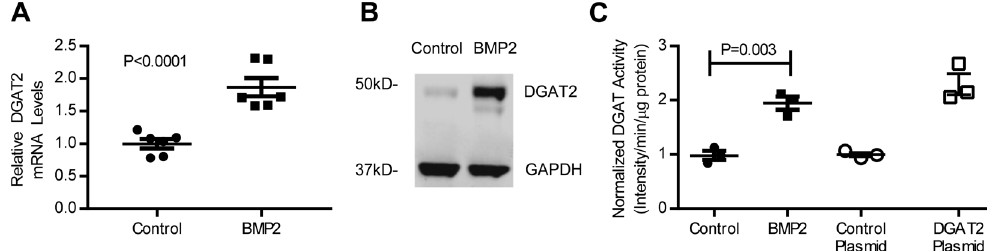
Figure 4. BMP2 increases DGAT2 expression and activity. Treatment of HepG2 cells with BMP2 resulted in increased expression of DGAT2 (diacylglycerol O-acyltransferase 2) mRNA ( A , six replicates per group) as well as increased DGAT2 protein levels at 24hrs ( B ). In parallel experiments, DGAT activity was assessed by quantification of fluorescently-labeled triglyceride production in HepG2 cells treated with BMP2 or control at 24hrs with DGAT2 overexpression and control plasmid as additional controls ( C , three replicates per group). Comparisons were made using the two-tailed Student’s t